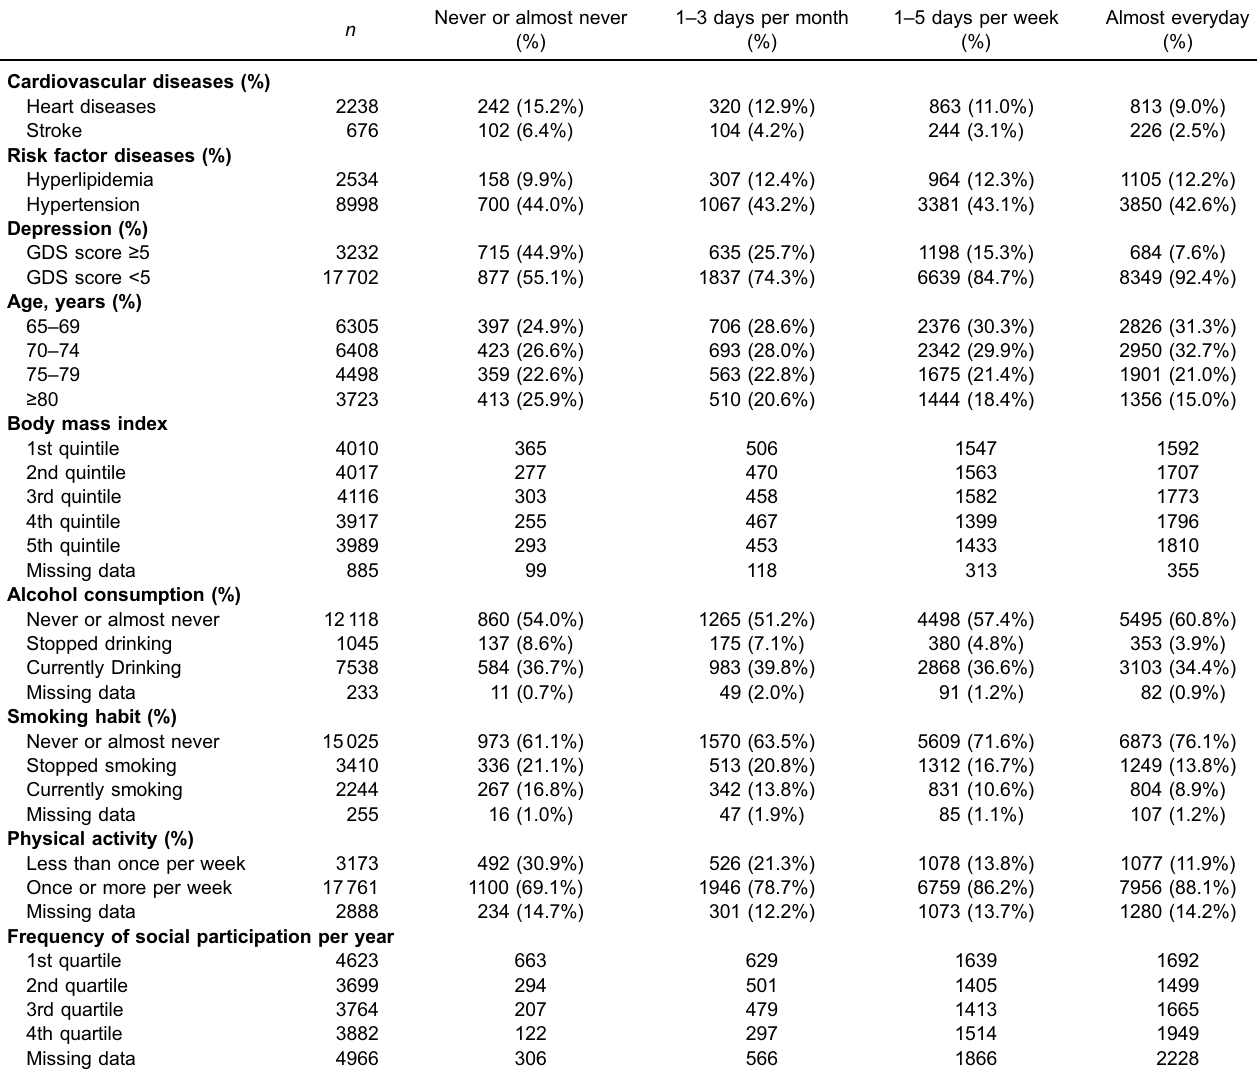
Table 1. Frequency of laughing in 4 weeks by participants ’ characteristics